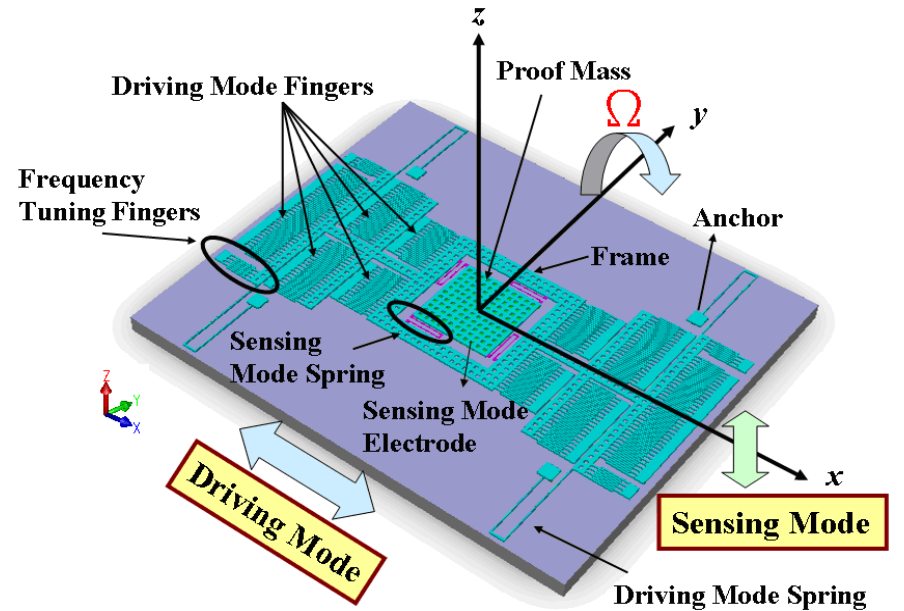
Figure 18. Out-of-plane